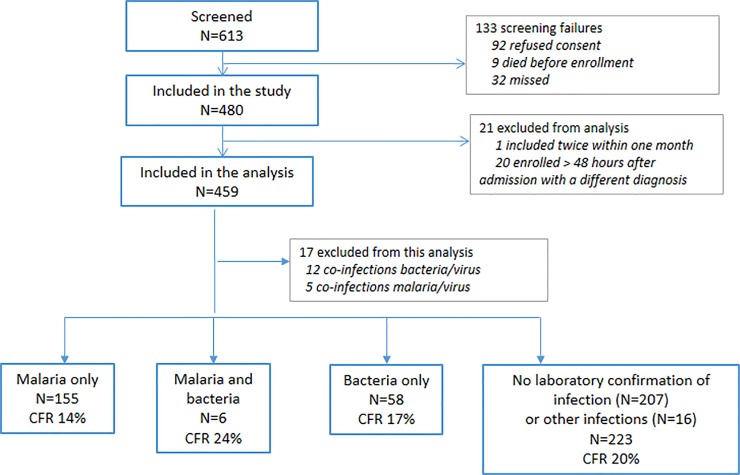
Study flow-chart.